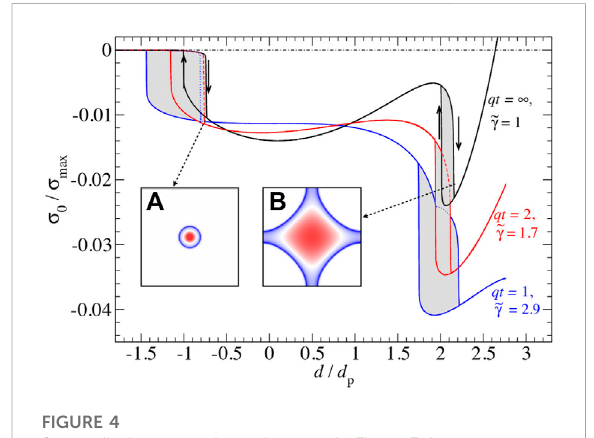
Stress-displacement dependence as in Figure 3, however, this time for ~ γ (cid:1) 1. Inset depicts the stress fi eld of the fi rst JKR-like jump into contact (A) and the second saddle-point contact near the moment where two patches merge. (B) The color blue indicates tensile stress while red represents repulsive stress.